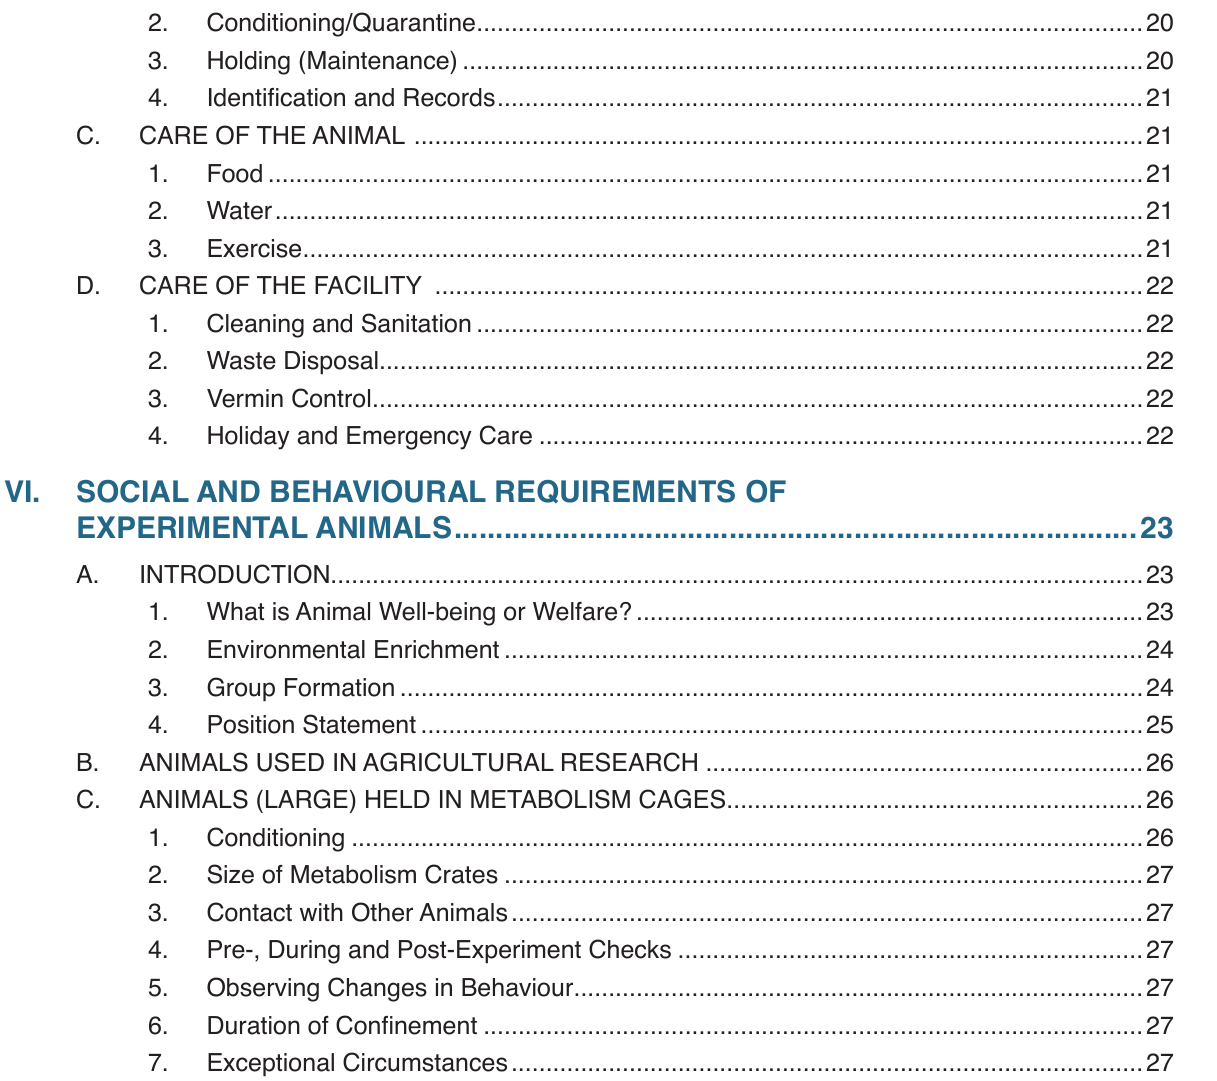
Guide to the Care and Use of Experimental Animals, Volume 1, 2 nd